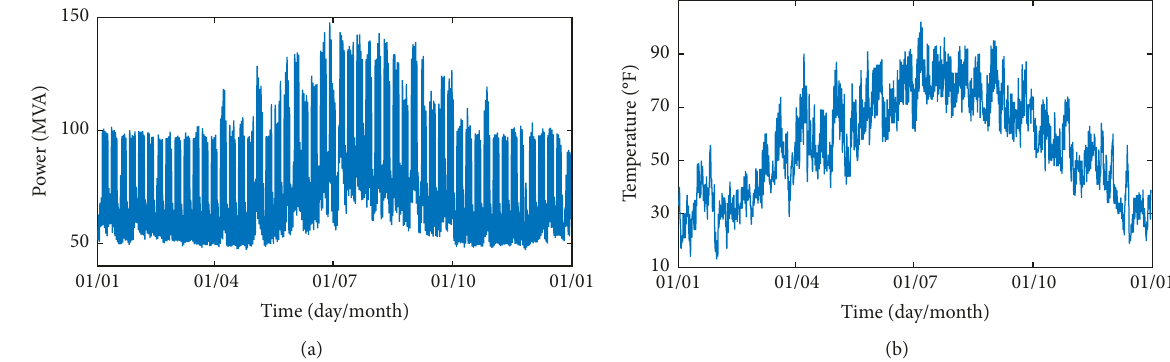
Figure 4: Actual load shape and outdoor temperature of one substation in NYC for 2010: (a) load shape; (b) outdoor temperature.